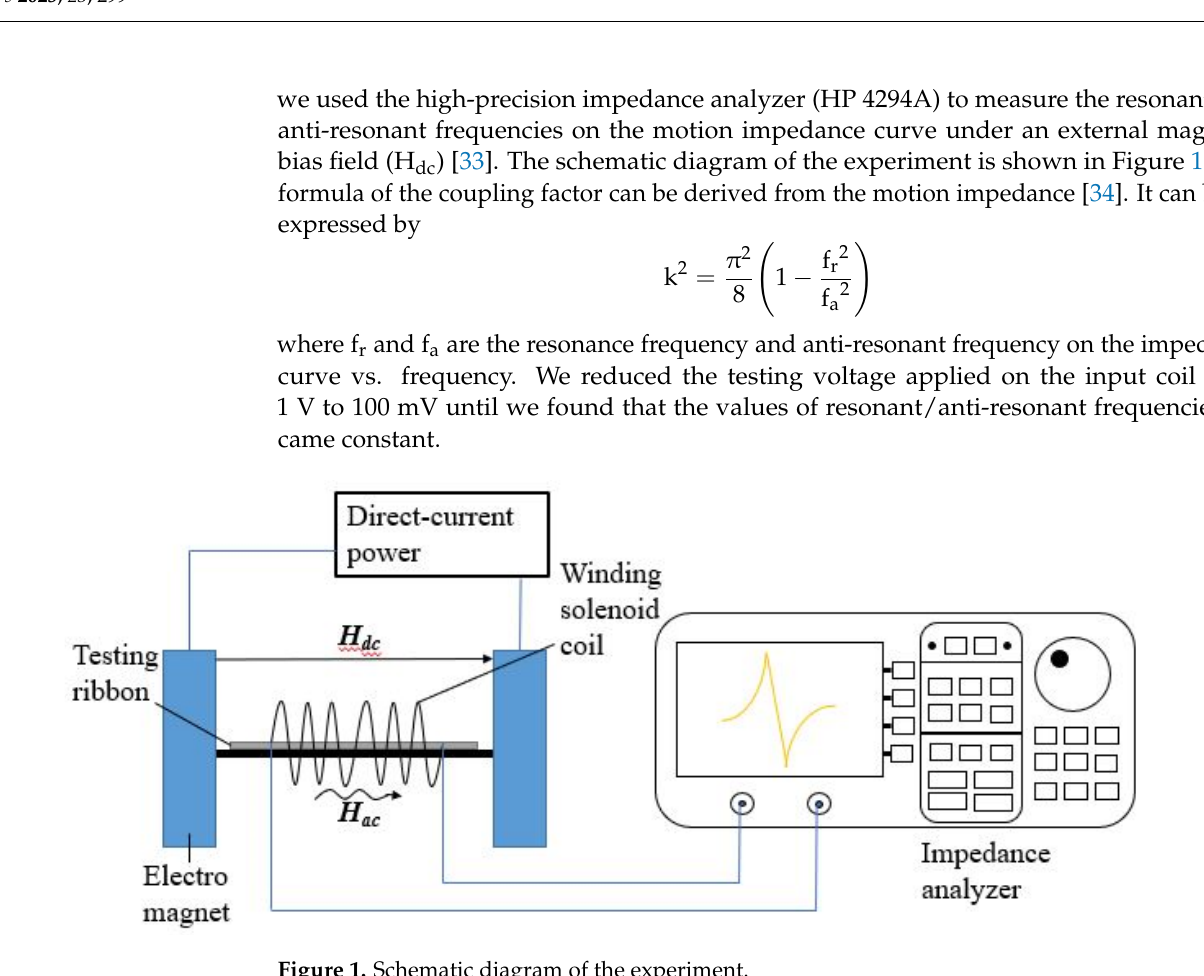
Figure 1. Schematic diagram of the experiment.